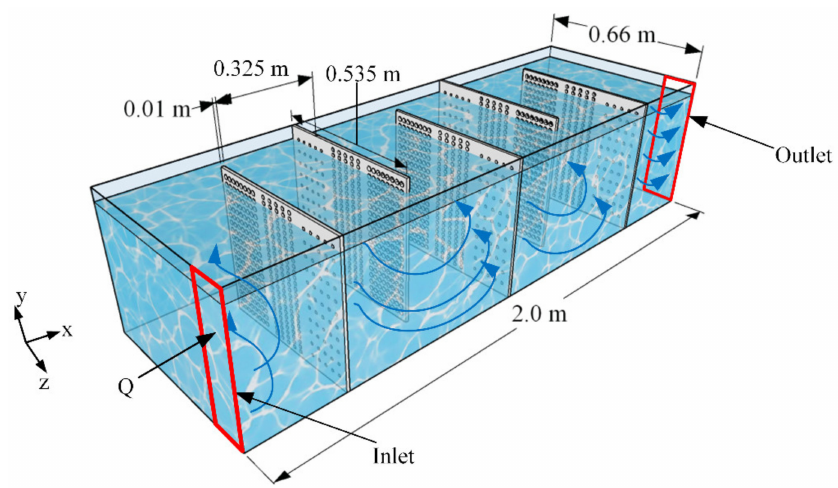
Figure 1. Schematic view of the contact tank with perforated ba ffl